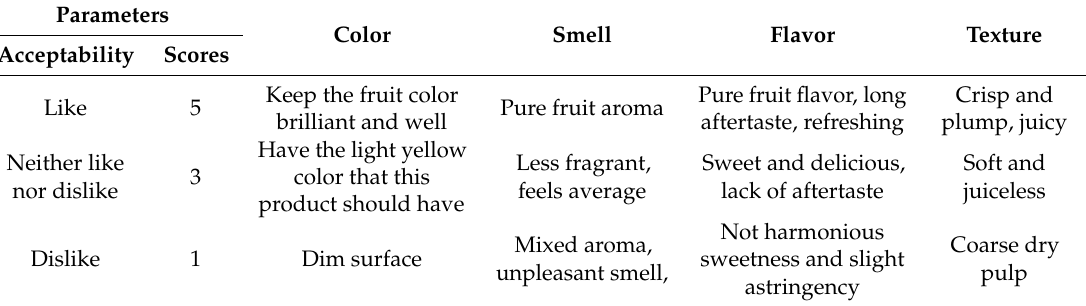
Table 2. Sensory evaluation